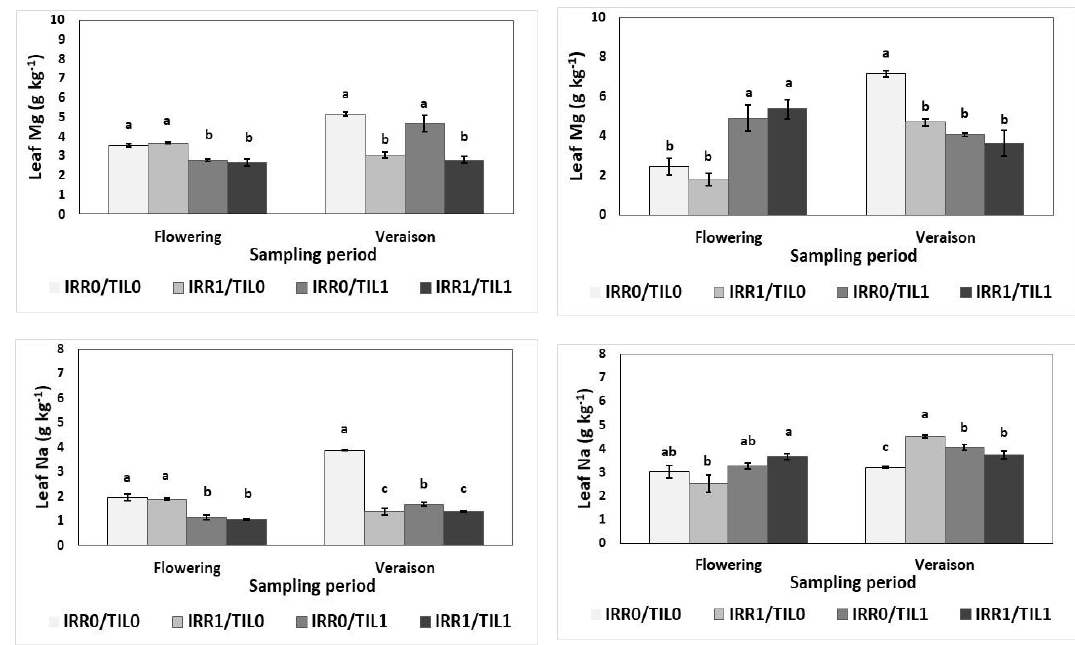
Figure 4. Impact of irrigation and tillage on the leaf content of macronutrients. Sampling dates were during flowering (1st sampling), and veraison (2nd sampling). Significant differences ( p < 0.05) among treatments are indicated by different letters according to Duncan’s multiple range tests. Error bars show SE ( n = 4). ns: not significant.